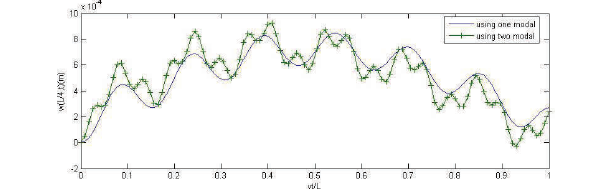
Figure 6. Displacement of qtr. Span with k=0 and v=20 m/s.